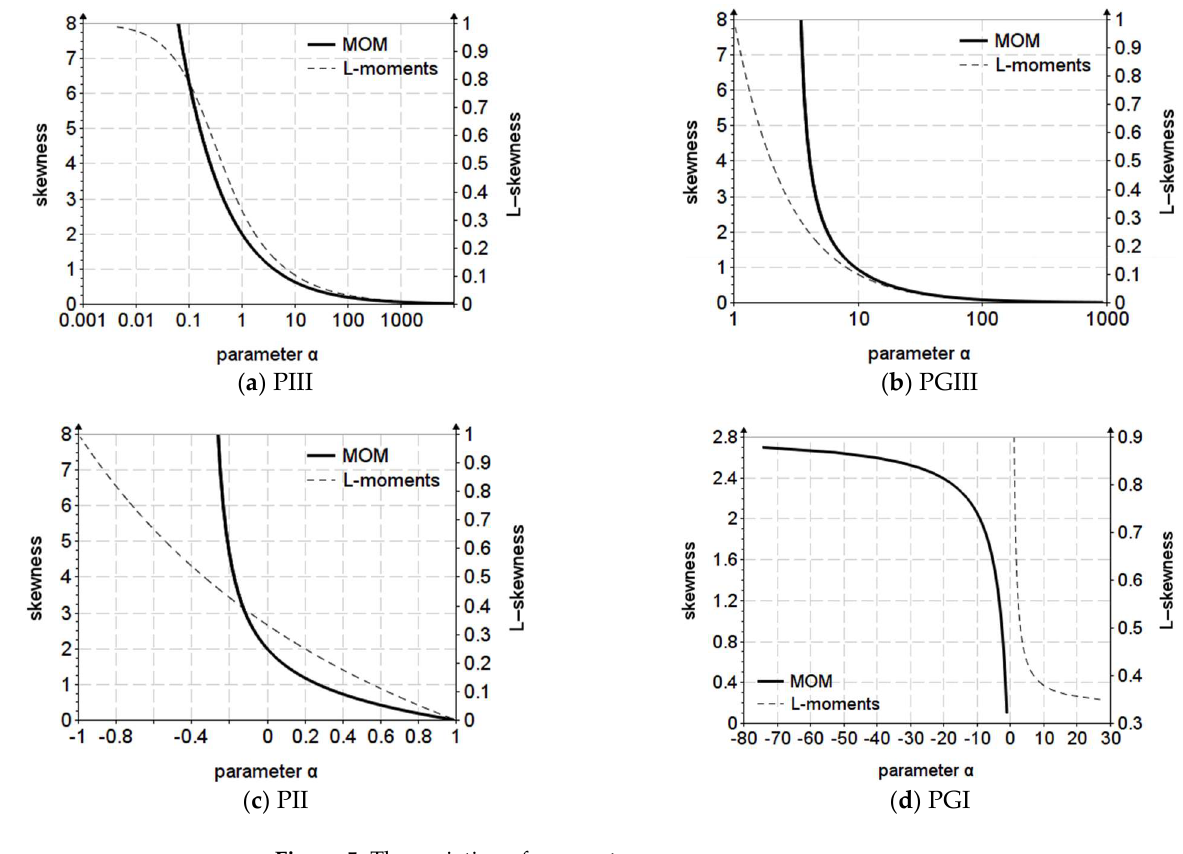
Figure 5. The variation of parameter α